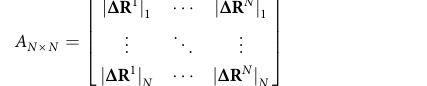
ffiffiffiffiffiffiffiffiffiffiffiffiffiffi q h Δ R ð Þ 2 i is the magnitude of fl uctuation response at site “ i ” due